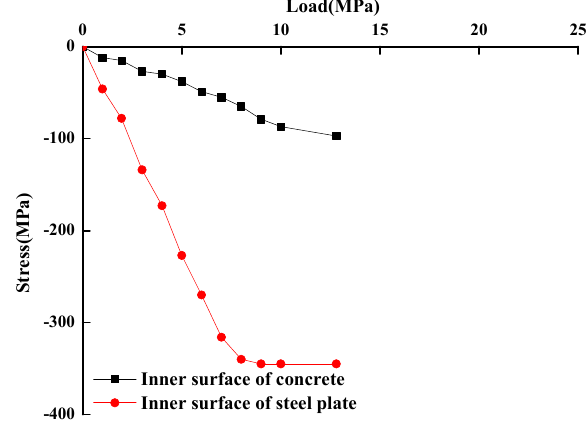
Figure 9. Load–hoop stress curve of specimen ZJ1.